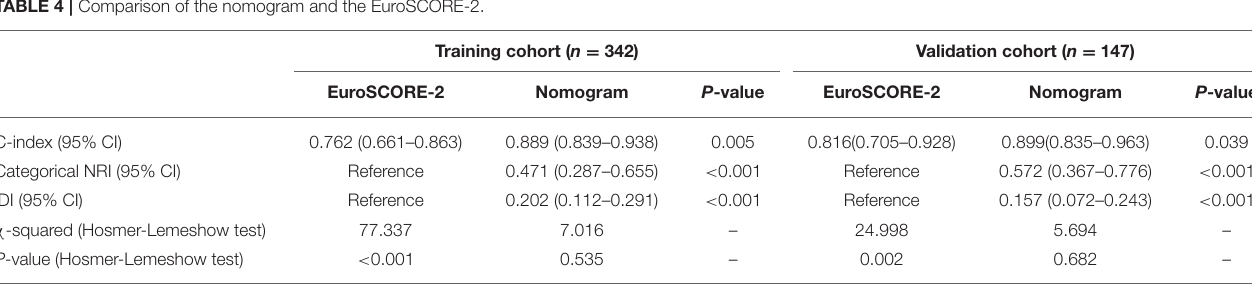
FIGURE 2 | The nomogram derived from training cohort for predicting mortality after CABG. MI, myocardial infarction; LVEF, left ventricular ejection fraction. TABLE 4 | Comparison of the nomogram and the